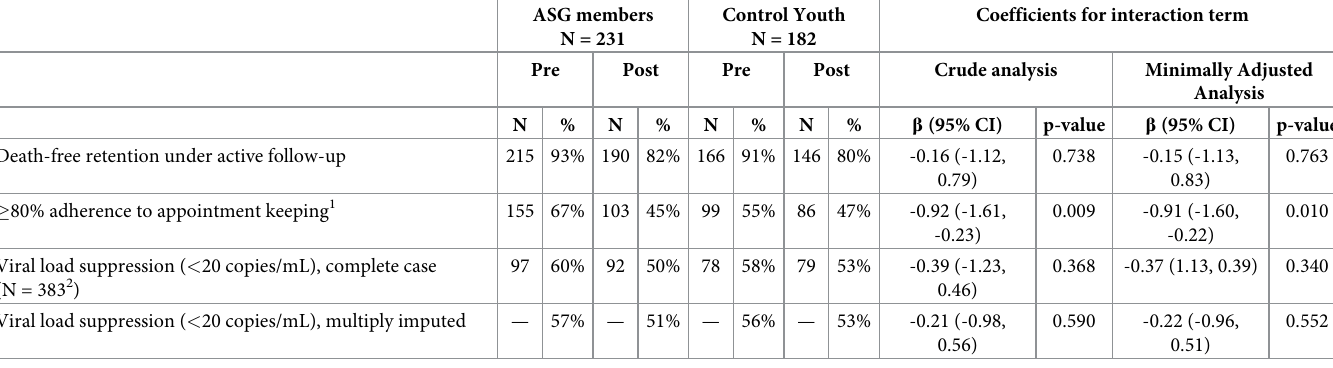
Table 5. Difference-in-difference estimates from generalized mixed models with a logit link and random intercepts for health facility and patient (N =